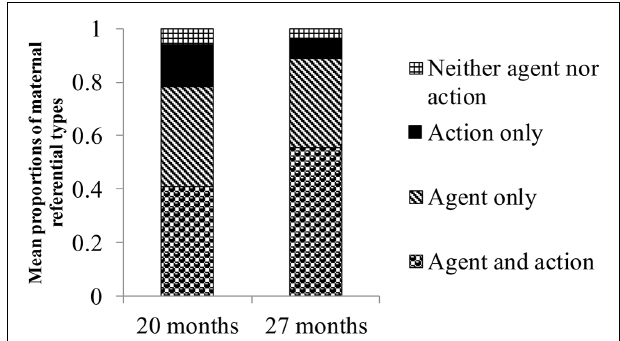
FIGURE 5 | Mean proportions of mothers’ and children’s referential types for information-giving and information-seeking utterances about a picture.